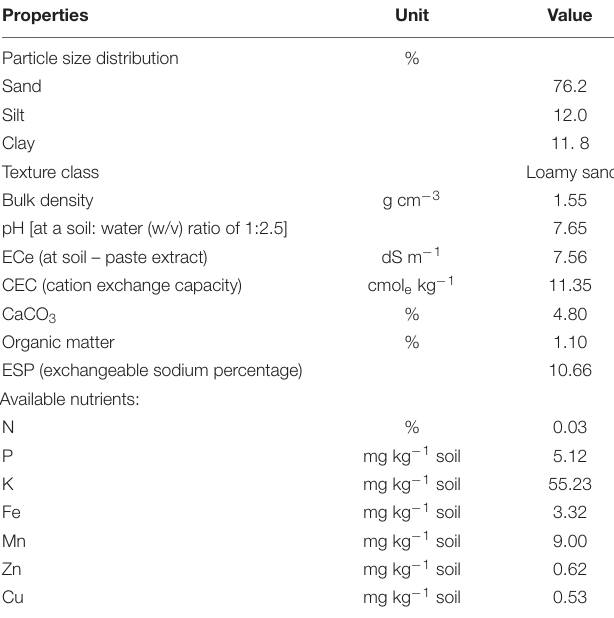
TABLE 1 | Some initial chemical properties of the experimental soil (as average for both